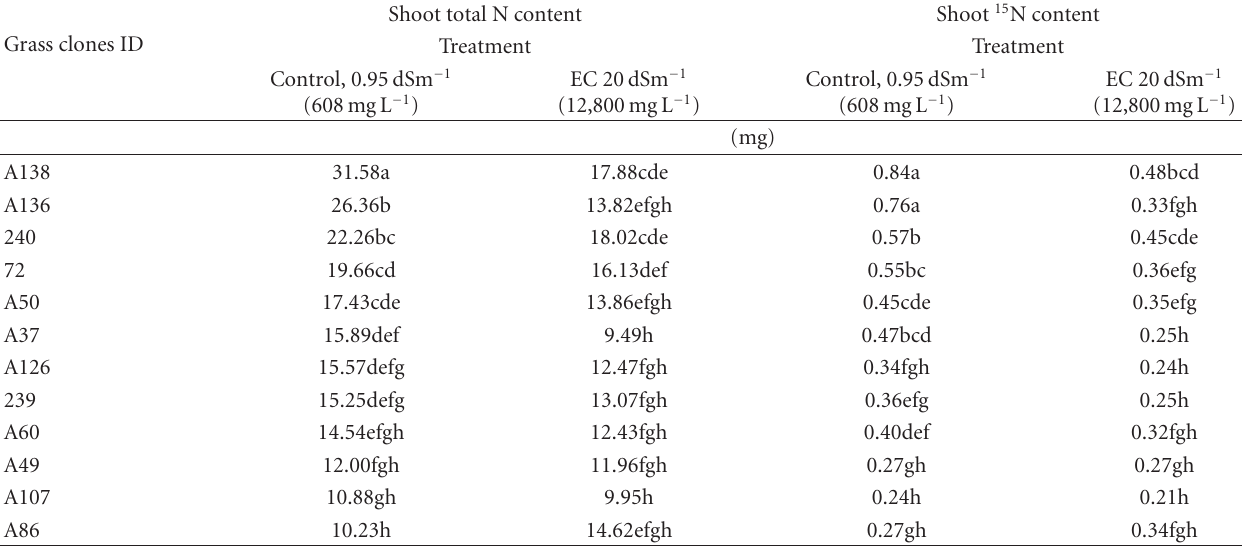
Table 5: Total nitrogen and 15 N contents (mg) of various clones of saltgrass shoot tissues under the control and salt (NaCl) stress conditions.